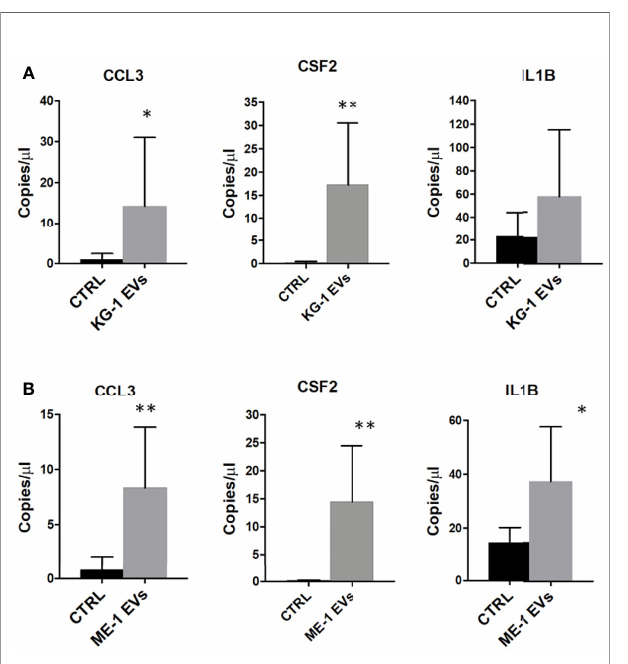
FIGURE 6 | In fl ammatory cytokines mRNAs in HSPCs treated with AML-EVs. Absolute quanti fi cation (copies/ m L) by ddPCR of CCL3 , CSF2 and IL1B in HSPCs treated or not (CTRL) with KG-1 (A) or ME-1 (B) derived-EVs. The bar- graphs represent mean + SD from three independent experiments. Statistically signi fi cant analyses are indicated by asterisks: *p < 0.05 and **p <